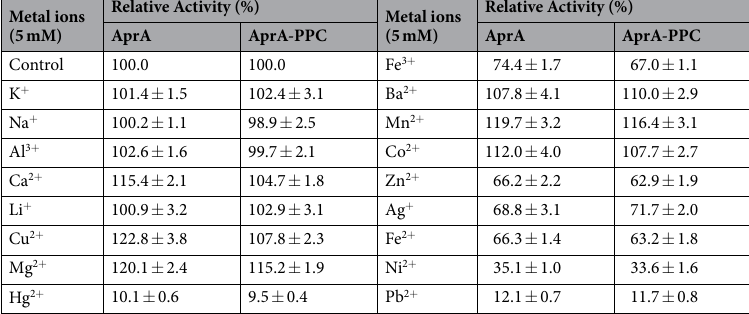
Table 2. Effects of metal ions on activity of recombinant AprA and